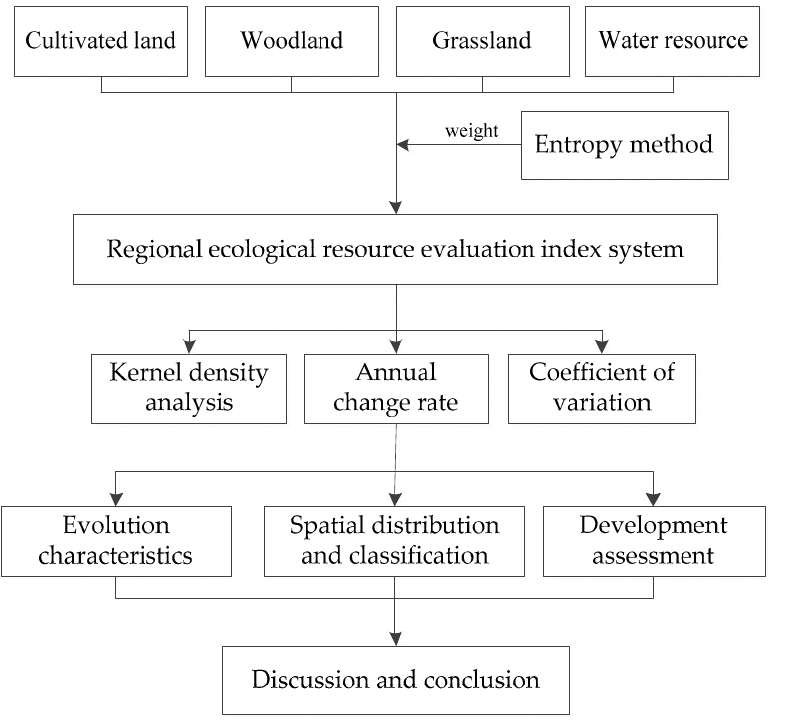
Figure 2. Research Figure 2. Research design.